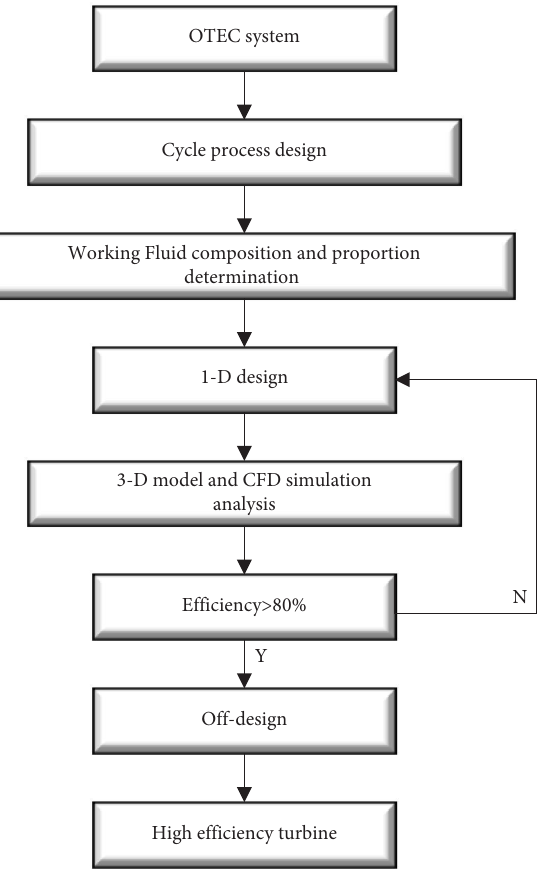
3: Te process chart of the